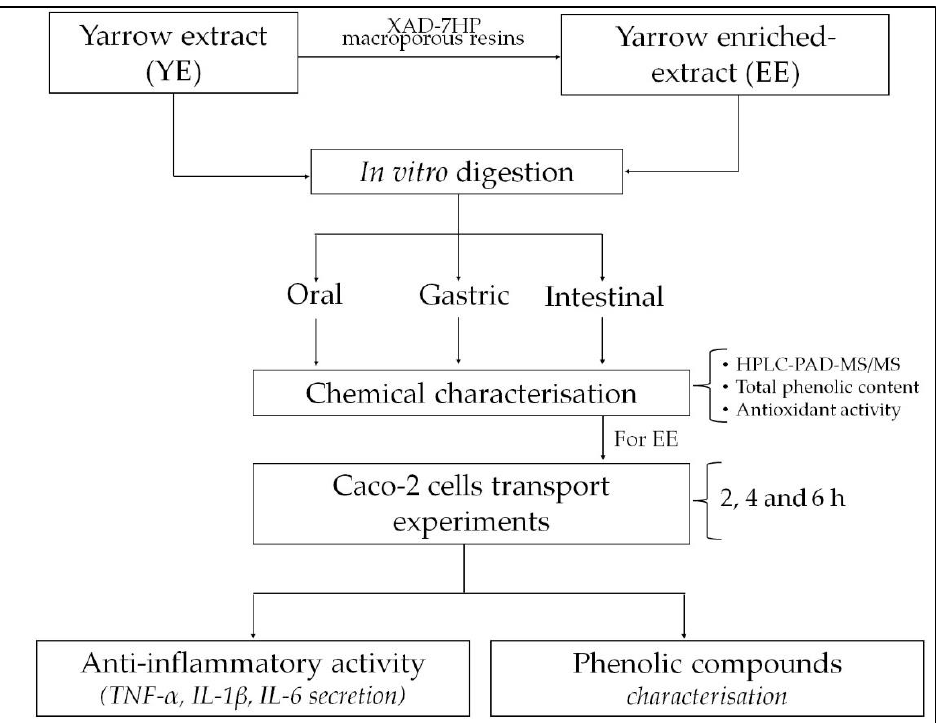
Figure 2. Flowchart summarizing the main experimental procedures for the bioavailability assess- ment of yarrow phenolic compounds.